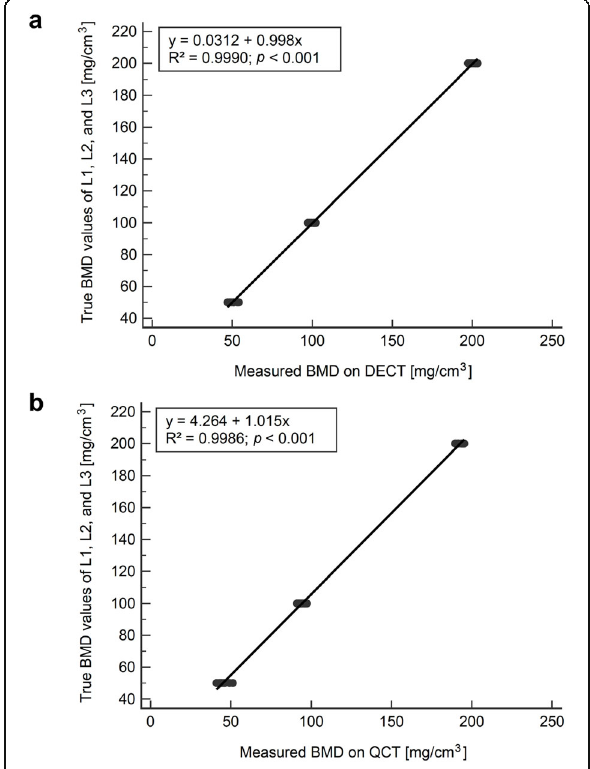
Fig. 6 Linear regression of BMD values in ( a ) DECT and ( b ) QCT. Scatter plots showing the relationship between true BMD values of L1, L2, and L3 ( y -axis) and measured BMD values obtained by DECT ( a ) or QCT ( b ) ( x -axis); the black lines represent the linear regression lines. A significant correlation between true and measured BMD values was identified, both in DECT ( R 2 = 0.9990; p < 0.001) and QCT ( R 2 = 0.9986; p < 0.001). BMD, Bone mineral density; DECT, Dual-energy computed tomography; QCT, Quantitative computed tomography; L, Lumbar vertebra equivalent; R 2 , Coefficient of